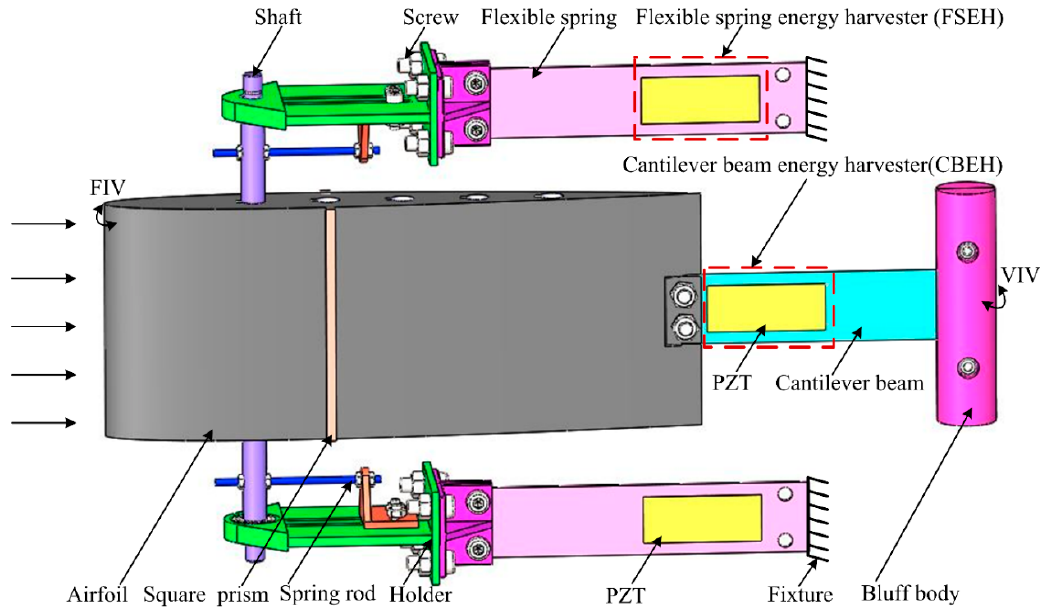
Figure 1. Schematic of the designed piezoelectric energy harvester system.